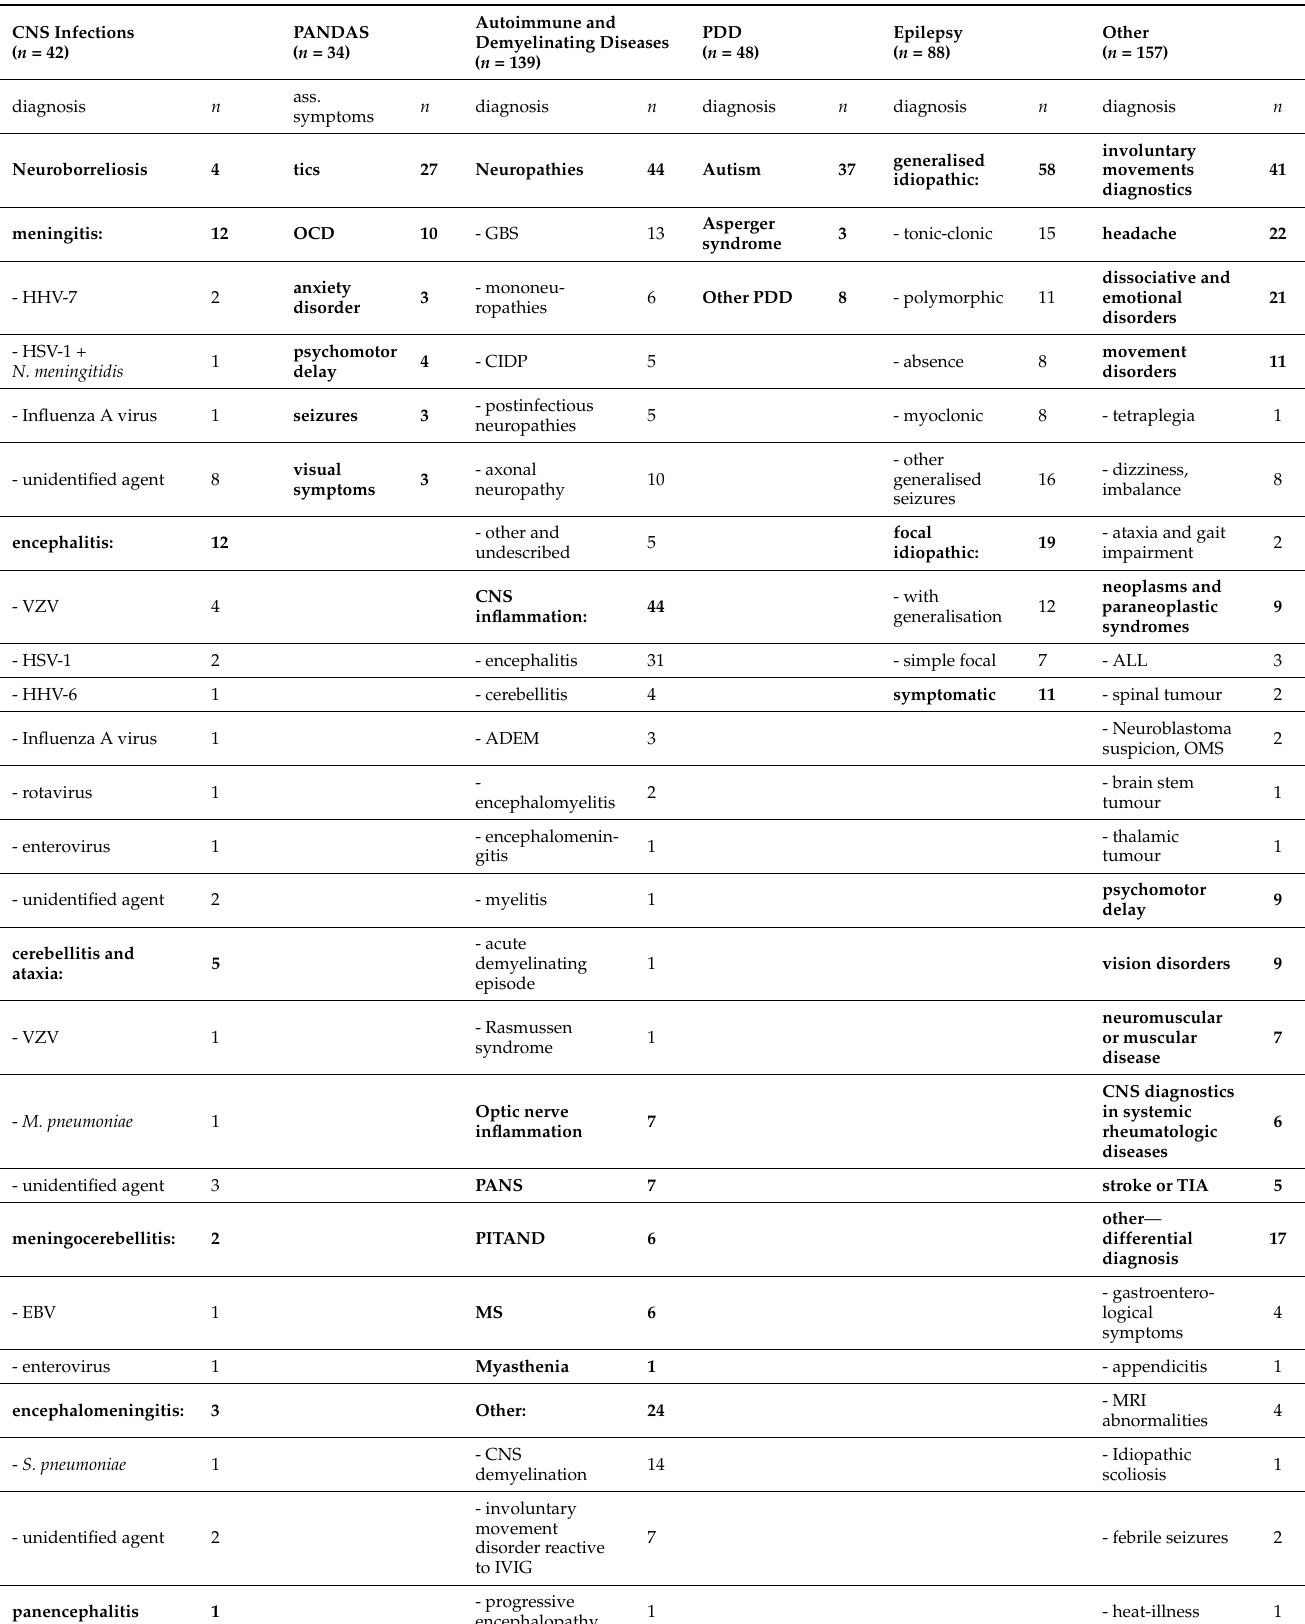
Table 1. Group sizes with subdivisions based on the final